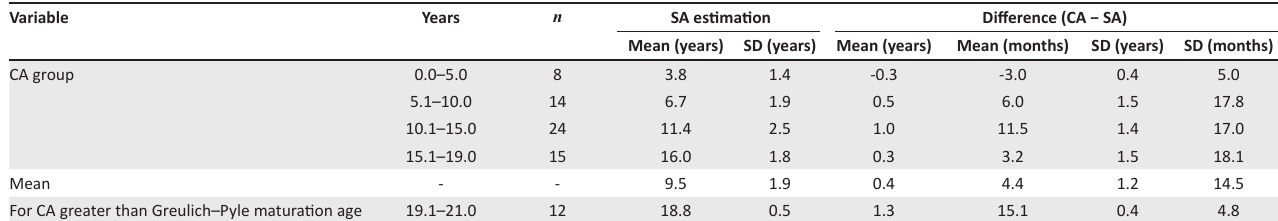
TABLE 2: Group analysis of difference between the skeletal age and chronological age for Reader 1 for various ages in male patients only ( N = 61). Variable